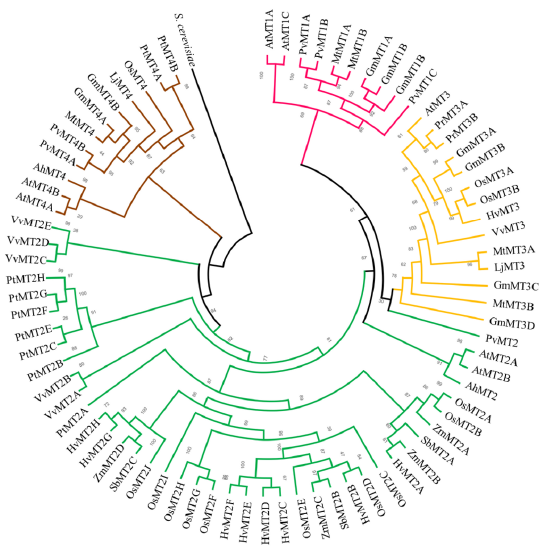
Figure 1. Evolutionary relationships among MTs. Rooted approximately maximum-likelihood phy- logenetic tree inferred from 77 MTs identified in 12 plant species: P. vulgaris (Ph), G. max (Gm), L. japonicus (Lj), M. truncatula (Mt), A. thaliana (At), V. vinifera (Vv), A. hypochondriacus (Ah), P. tricho- carpa (Pt), O. sativa (Os), S. bicolor (Sb), Z. mays (Zm), and H. vulgare (Hv). The clades are shown in different colors according to the MT classes: MT1, pink; MT2, green; MT3, yellow; MT4, brown. A sequence from Saccharomyces cerevisiae was used as the outgroup. The phylogenetic tree was con- structed using IQ-TREE software with the Dayhoff substitution model with 1000 bootstrap itera- tions.